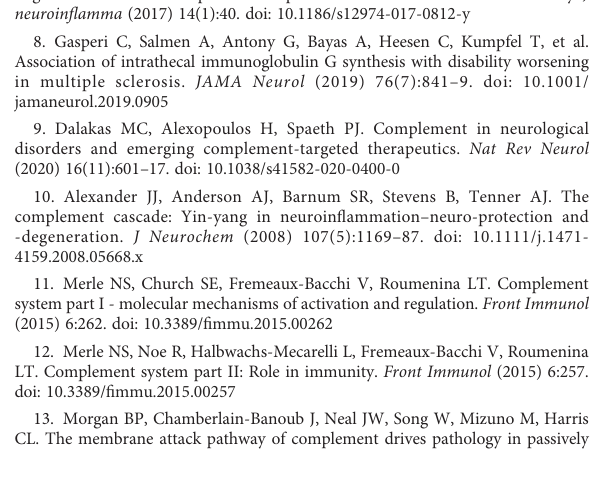
SUPPLEMENTARY FIGURE 1 Clinical disease progression in TMEV-IDD and rEAE mice included in this study. Disease progression of TMEV-IDD (A) and rEAE (B) over their respective monitor periods post-induction. Each plot indicates the time points chosen for analysis of CNS tissue: TMEV-IDD mice were necropsied at around 120 dpi to capture the chronic progressive phase of the disease. rEAE mice were necropsied around 15 dpimm to capture the acute phase of the fi rst relapse. (A) The Rotarod Test was performed on 26 TMEV-infected mice and 10 age-matched sham controls over an average of 120 dpi. Eight were excluded from the experiment because they tested TMEV-negative at the end of their follow-up. Rotarod data were expressed as a neurological function index (NFI) (29). (B) Clinical symptoms score (CSS) from day 1 to day 15 dpimm of 20 rEAE mice. Four mice were withdrawn from the experiment because not symptomatic at the end of the follow up. The circles and con fi dence bars represent the mean and the SEM of the (A) NFI or (B) CSS of the entire group of mice for each day p.i. Blue circles represent diseased mice and orange squares represent sham-treated controls.